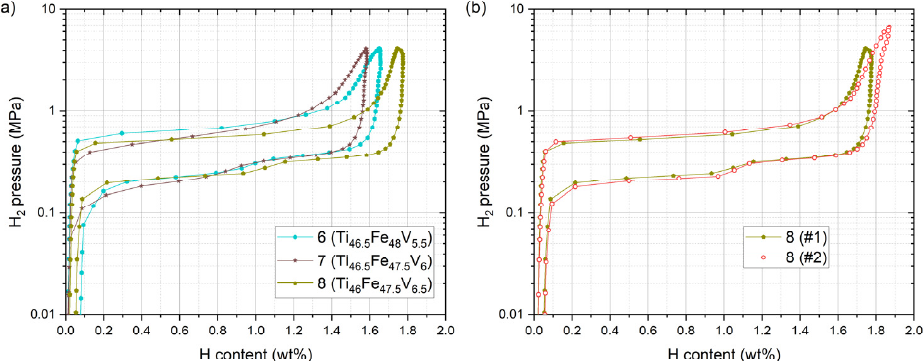
Figure 9. ( a ) PCI curves for samples 6, 7, and 8 at 30 ◦ C. ( b ) Comparison of the two independently measured PCI curves for sample